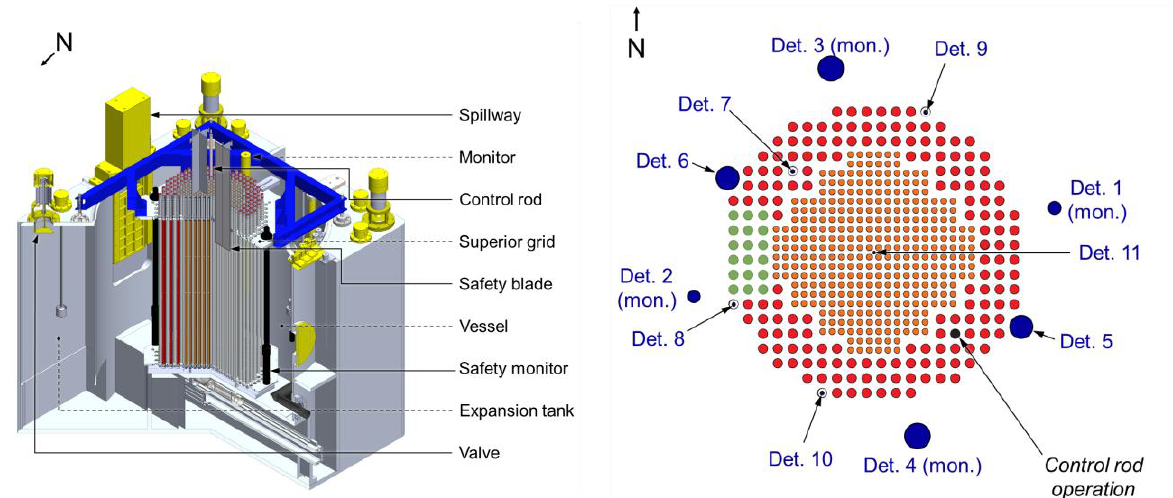
Figure 1. View of the vessel of the CROCUS reactor (left), and top view of the campaign configuration (right) with location of perturbation (green), neutron detectors (blue), and control rod (black). The core is located in an Al-6060 grade vessel of 130 cm in diameter, 160 cm in height, and 1.2 cm in thickness. The vessel is filled with demineralized light water used as both moderator and reflector. The core active part has the approximate shape of a cylinder of 100 cm in height and about 60 cm in diameter. It consists of two interlocked fuel zones with square lattices of different pitches: an inner zone of 336 UO rods with an enrichment of 1.806 wt.% and a pitch of 1.837 cm; an outer zone of 176 U experiments, 0.947 wt.% and 2.917 cm; a varying water gap between the two zones because of the two different pitches. The picture of the reactor and critical assembly configuration is shown in Figure